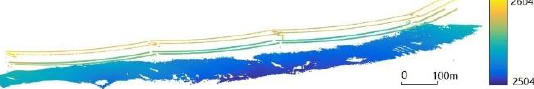
Figure 7. Power line candidates. The color bar represents the real height